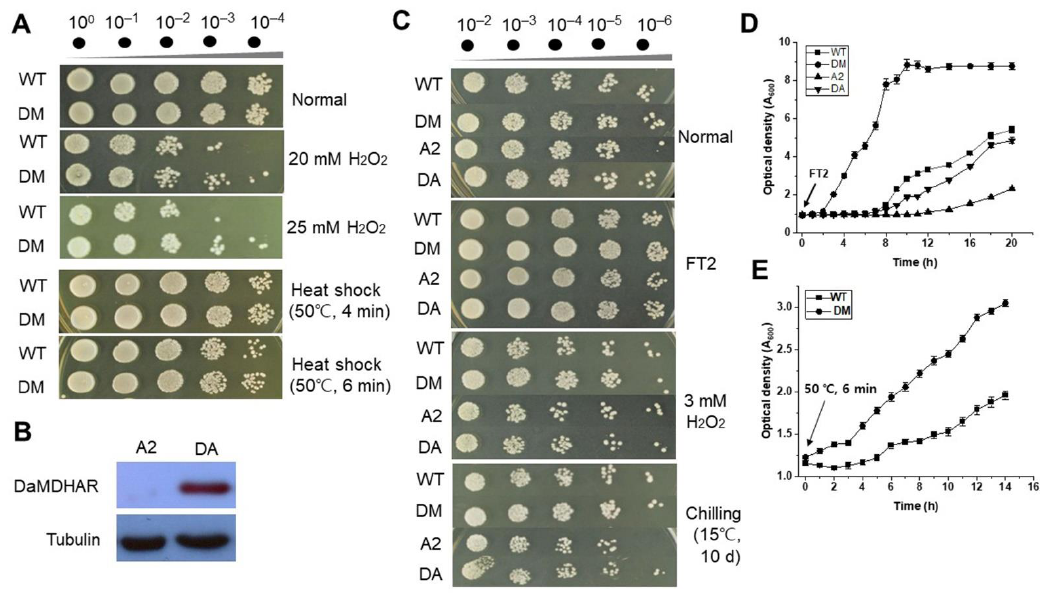
Figure 8. Cellular response in DaMDHAR -expressing yeast cells to oxidative stress and heat shock. ( A ) Exponential yeast cells (A 600 ≈ 1.5) were exposed to 20 and 25 mM H 2 O 2 for 1 h at 28 ◦ C with shaking (160 rpm) and diluted to 10 − 4 with YPD broth. For heat shock, the same-phase yeast cells were challenged for 4 and 6 min at 50 ◦ C. Five microliters of the diluted solution were spotted onto the YPD agar broth, incubated at 28 ◦ C, and then visualized. ( B) Construct in DaMDHAR -expressing yeast cells using D-erythroascorbate (eAsA) instead of ascorbate as a substrate. The deleted strain ( ara2 ∆ ) of the ARA2 gene encoding NAD-dependent arabinose dehydrogenase was employed. After establishing DaMDHAR -expressing ara2 ∆ (DA) cells and ara2 ∆ (A2) cells with empty vector alone via transformation, protein expression in both cells was confirmed by western blot analysis. ( C ) Cellular response assay to abiotic stress was performed using the spotting assay. Exponential yeast cells (A 600 ≈ 1.5) grown in YPD broth were serially diluted to 10 − 6 with YPD broth. Five microliters of each diluted solution were spotted onto the YPD agar medium in the absence and presence of 3 mM H 2 O 2 and incubated for 3 days at 28 ◦ C or 10 days at 15 ◦ C. For FT, exponential cells were exposed to repeated FT cycles (FT2), diluted with YPD broth, spotted onto the YPD agar medium, and incubated for 3 days at 28 ◦ C. ( D ) Growth kinetics after FT2 stress. Log-phase yeast cells exposed to FT2 stress were resuspended into a fresh YPD broth medium and incubated at 28 ◦ C for 20 h with shaking (160 rpm). Optical density was measured every 2 h at 600 nm. ( E ) Cellular response to heat shock in DaMDHAR -expressing yeast cells. Log-phase yeast cells exposed to heat shock at 50 ◦ C for 6 min were harvested by centrifugation and resuspended into a fresh YPD broth medium. Optical density was measured at 600 nm in 1 h-interval for 14 h. WT, wild-type cells with empty vector; DM, DaMDHAR -expressing transgenic cells. WT, wild-type cells with empty vector; DM, DaMDHAR -expressing transgenic cells; A2, ara2 ∆ cells with empty vector alone; DA, DaMDHAR -expressing ara2 ∆